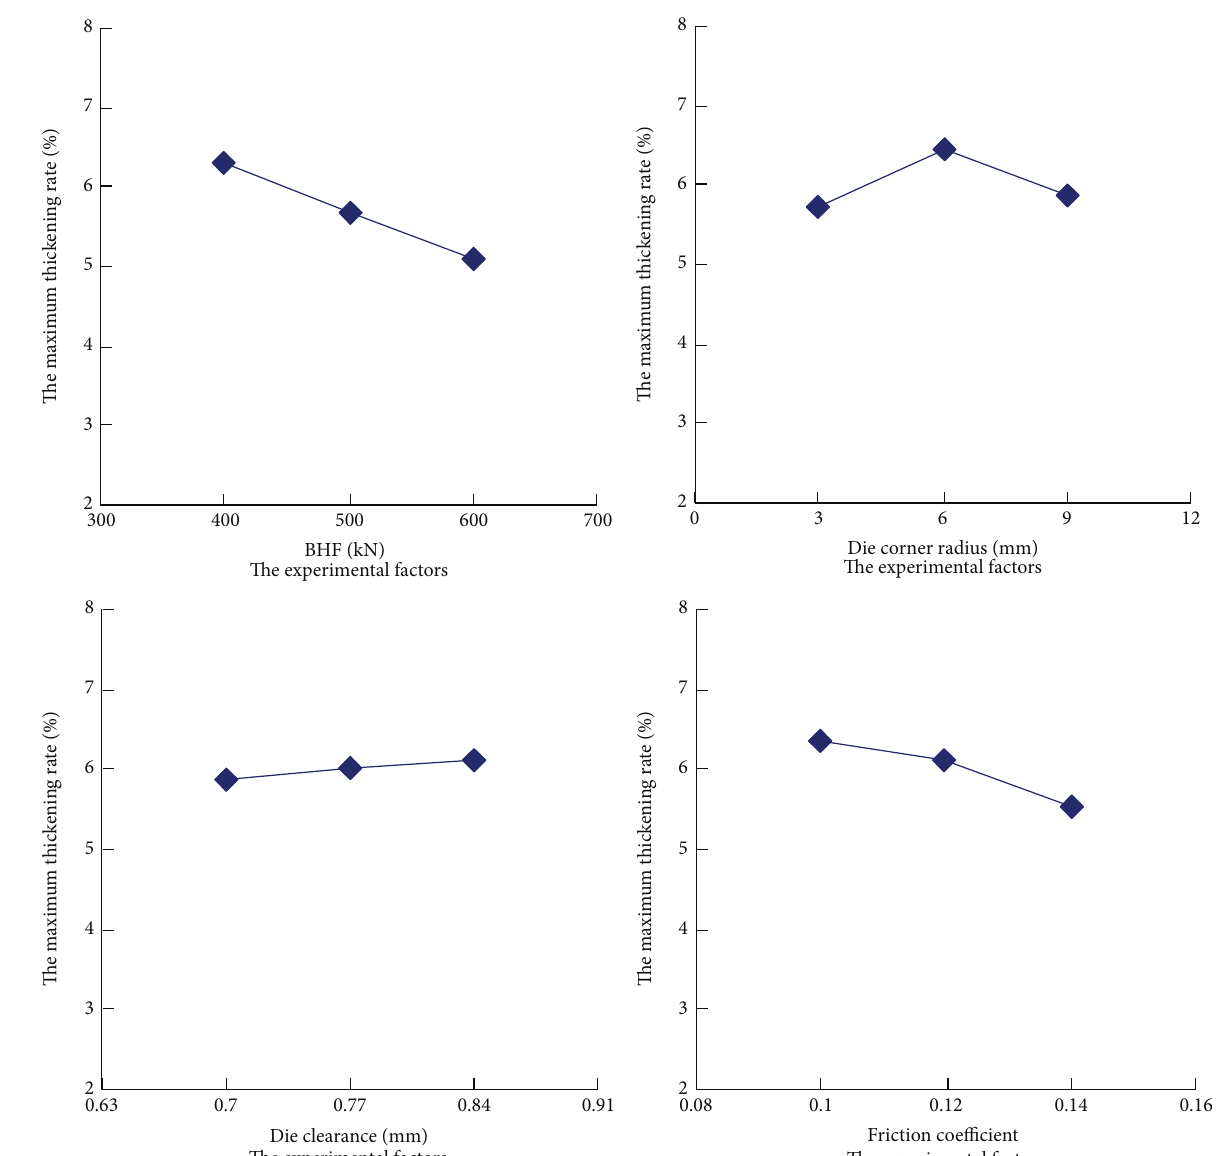
Figure 5: Relationship between the maximum thickening rate and experimental